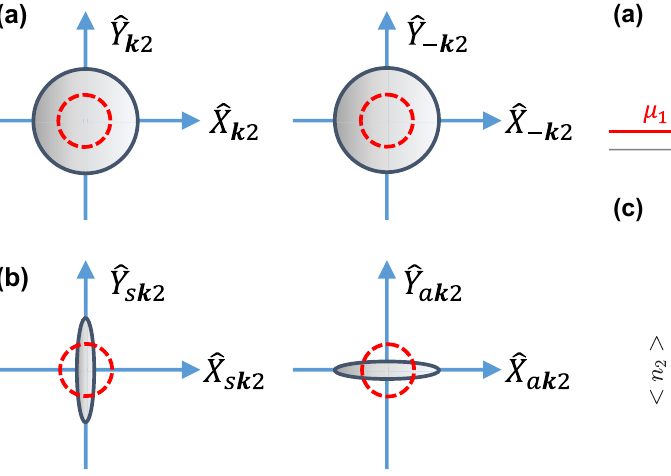
Figure 3: Phase space (quadrature plane) representation after the temporal boundary. (a) Schematic representation of the quadrature operator variances for the forward (left) and backward (right) modes with wavenumber k . (b) Same as in (a), but in the symmetric (left) and asymmetric (right) basis, showing squeezing along different axis. For comparison, vacuum state variances (phase space representation before the temporal boundary) is included as a dashed red circle.